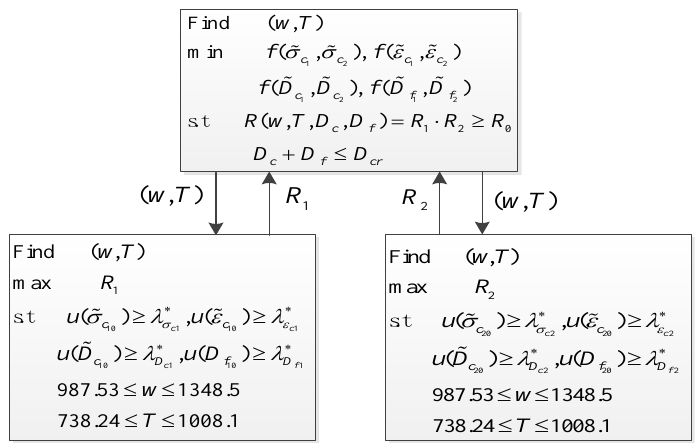
Figure 10. Fuzzy probabilistic fatigue / creep optimization model of a bladed disk. Table 5. Optimized results of a bladed disk.